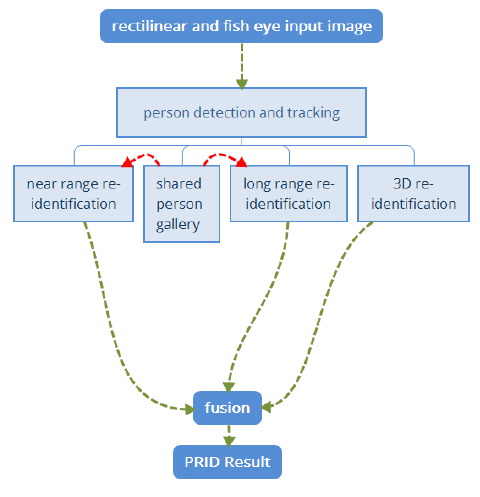
Figure 2. Security camera image taken from 4m camera height, 30 ◦ pitch angle towards ground and 97 ◦ camera opening angle. Figure 3. Bifocal PRID processing